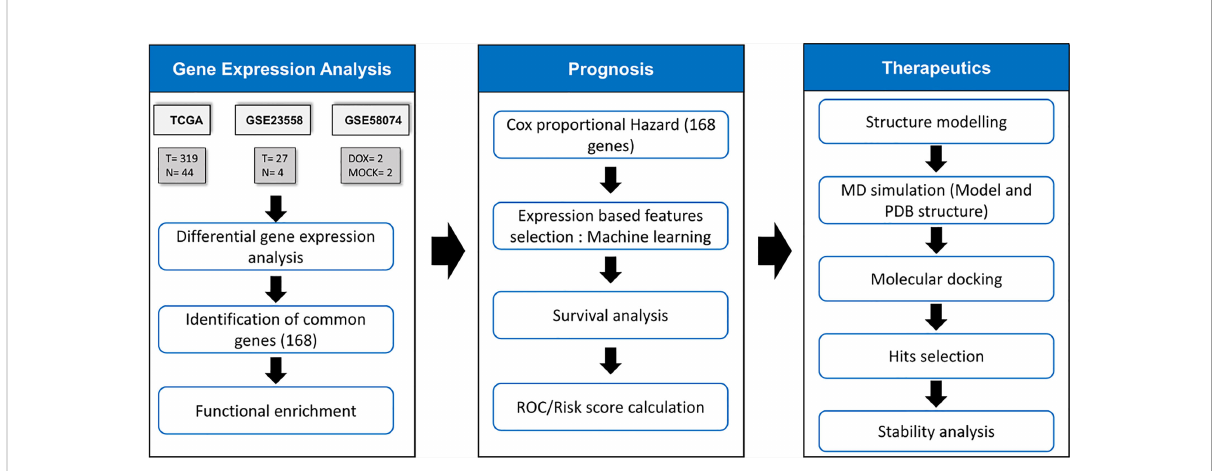
FIGURE 1 Methodology for identi fi cation of drug response related signature and identi fi cation of their inhibitors. The TCGA samples had 319 OSCC & 44 normal samples. GSE23558 had 27 OSCC patients ’ data. GSE58074 examined the effect of doxorubicin on SCC25 cell lines to check for molecular markers underlying doxorubicin